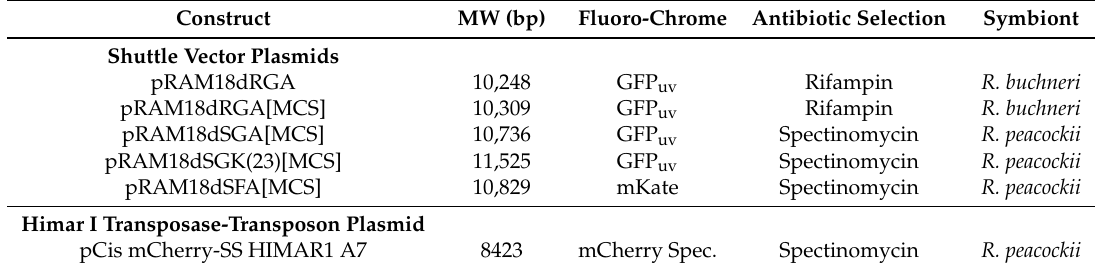
Table 1. Plasmid constructs used for the transformation of Rickettsia buchneri and Rickettsia peacockii